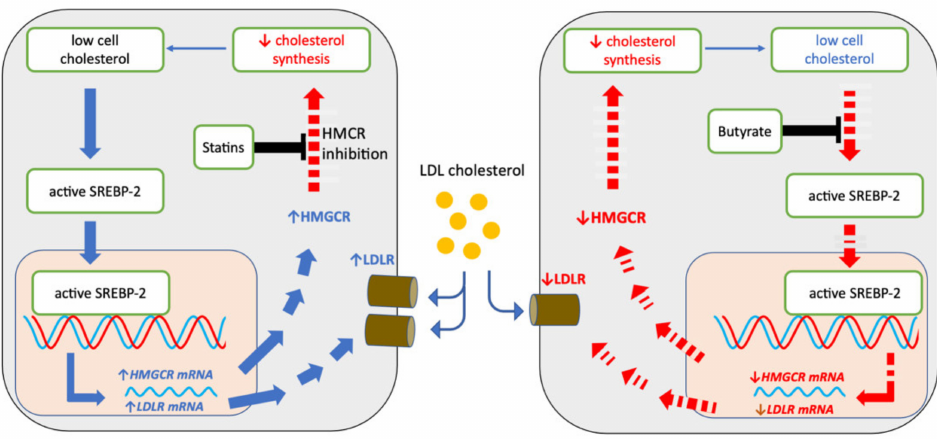
Figure 10. Influence of statins and that postulated for butyrate on cell cholesterol metabolism in HepG2 cells. Processes which are decreased with statin or butyrate treatment are shown in red. Statins inhibit HMGCR activity and thereby decreases de novo cholesterol synthesis, resulting in increased cleaved or active SREBP-2 which upregulates the expression of gene and protein expression of HMGCR and LDLR, the latter resulting in increased LDL cholesterol uptake. HMGCR protein is upregulated, but its activity remains inhibited by statins. Butyrate treatment is associated with decreased cleaved SREBP-2 activity resulting in decreased expression of HMGCR and LDLR gene and protein expression, resulting in decreased de novo synthesis and decreased LDL cholesterol